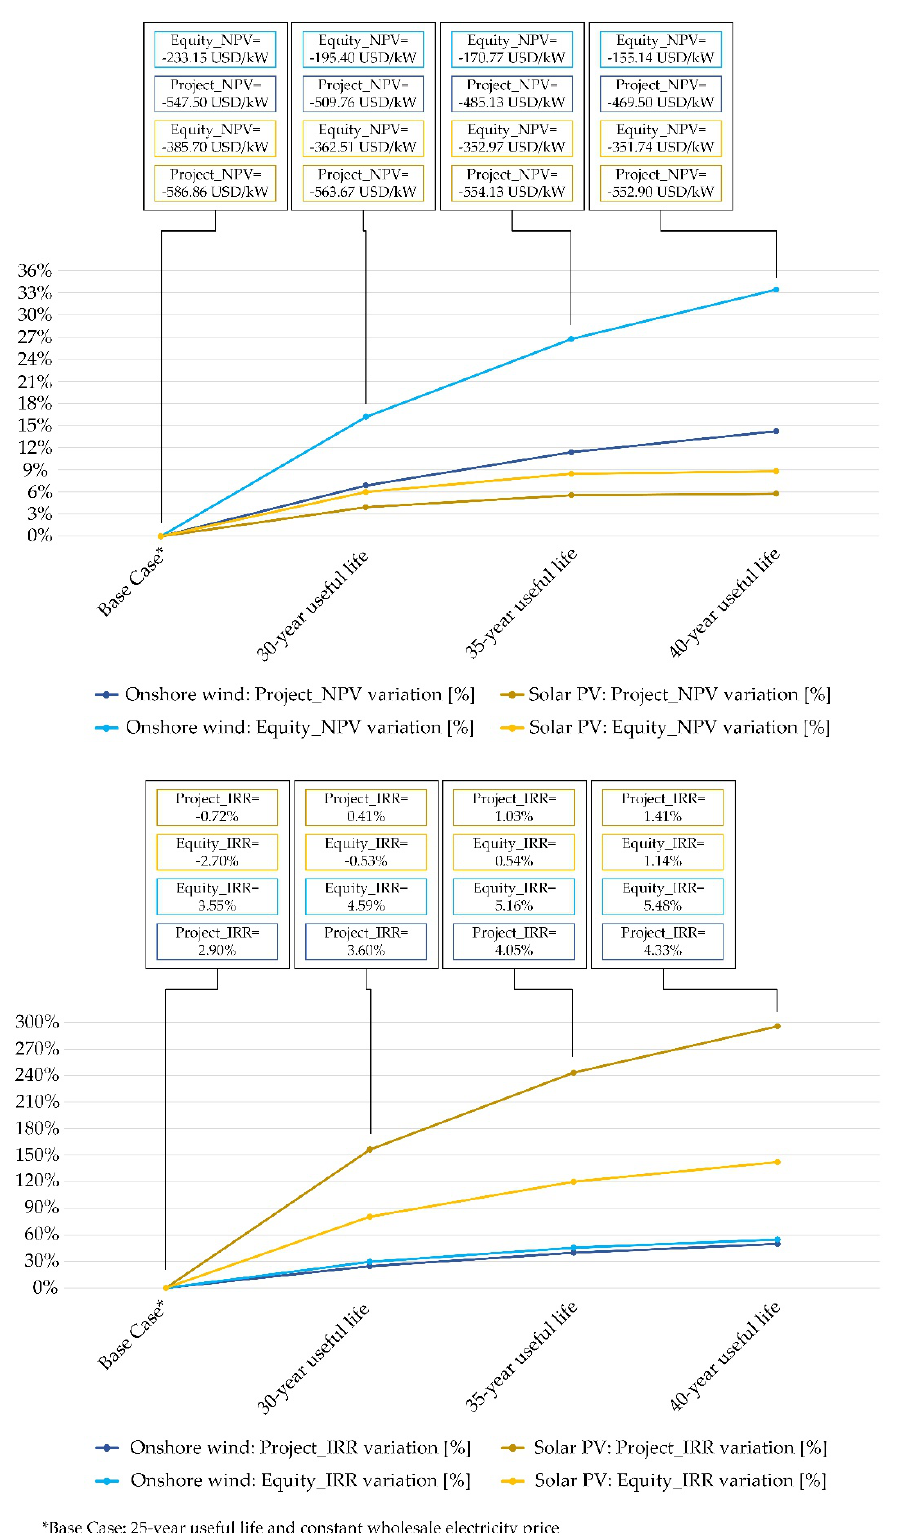
Figure 8. Project and equity NPV percentage variation (upper subplot) and project and equity IRR percentage variation (lower subplot) with the useful life for the Danish case. Source: self ‐elaboration.